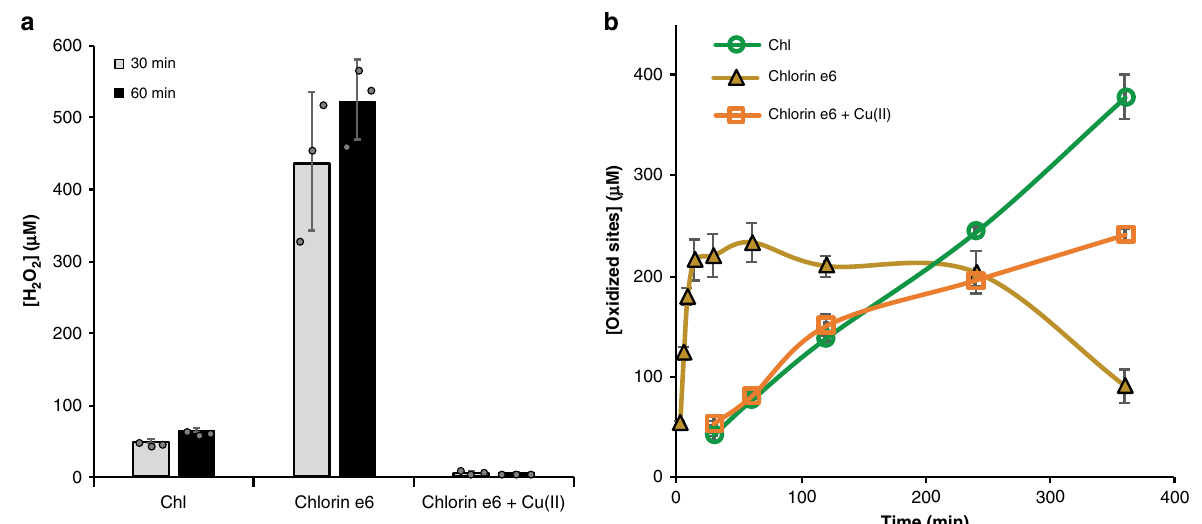
Fig. 5 Effect of copper on H 2 O 2 generation by light-exposed Chl and chlorin e 6 and on light-driven LPMO activity. a H 2 O 2 production by 500 µ M of light-exposed Chl, chlorin e 6 or chlorin e 6 supplemented with 0.9 molar equivalents of Cu(II). b Time-course release of soluble aldonic acid products released from Avicel by Sc AA10C (1 µ M) when fueled by light-exposed Chl, chlorin e 6 or chlorin e 6 complemented with 0.9 eq. Cu(II). All reactions were carried out with 500 µ M pigment and exposed to visible light ( I = 25% I max , approx. 42 W cm − 2 ), in sodium phosphate buffer (50 mM, pH 7.0) at 40 °C, under magnetic stirring. Before product quanti fi cation, solubilized cello-oligosaccharides were hydrolyzed by Tf Cel5A, to convert the LPMO products to a mixture of only two oxidized products with a degree of polymerization of 2 and 3 [GlcGlc1A, (Glc) 2 Glc1A], the amounts of which were summed up to yield the concentration of oxidized sites. Error bars show ± s.d. ( n = 3, independent experiments). Source data are provided as a Source Data fi le.